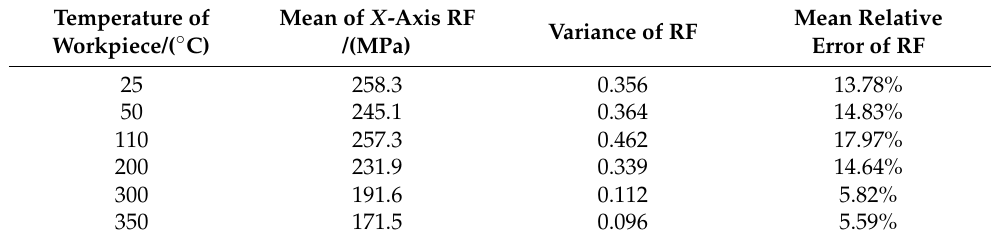
Table 9. Data analysis of reaction force in the X-axis direction.